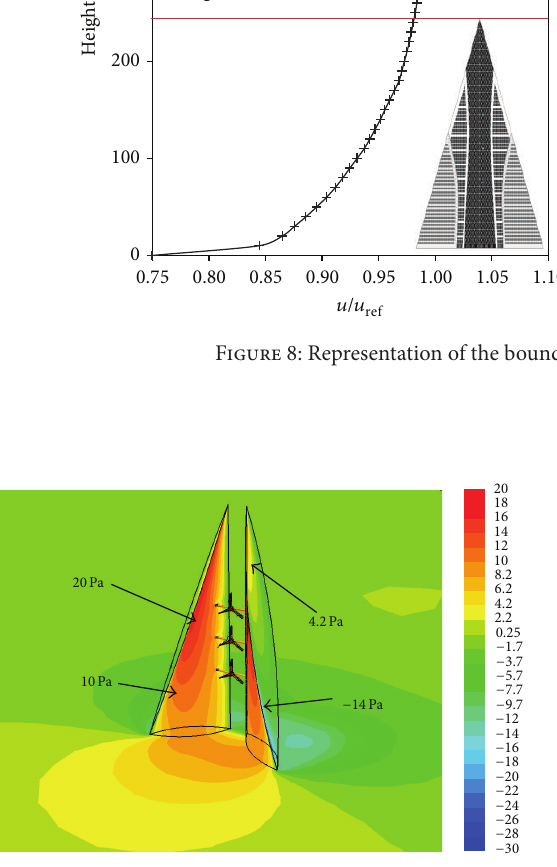
Figure 11: Contour levels of turbulence kinetic energy upstream and downstream of the